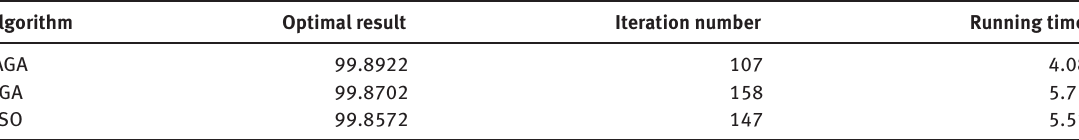
Table 10: Comparison of the Performance of the IAGA, SGA, and PSO.